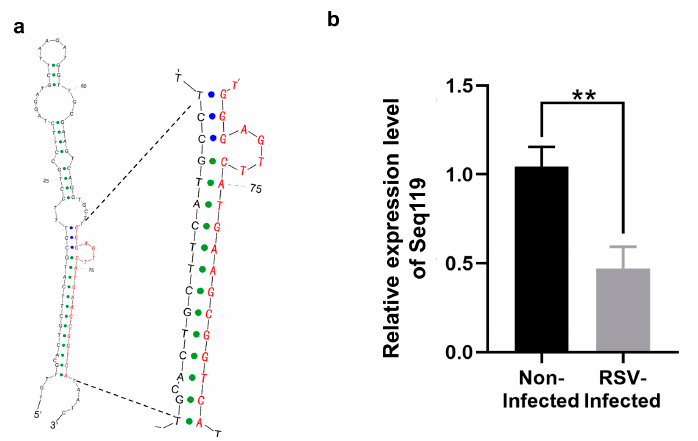
Figure 1. Predicted secondary structures of Seq119 precursor ( a ) and its downregulated expression in RSV-infected rice plants ( b ). Sequences of the putative mature miRNA in precursors are colored with red letters. The relative expression level of Seq119 in RSV-infected rice leaves was analyzed via qRT-PCR. Values are means ± SD. Student’s t test was used to test the significance of the difference (**, p < 0.01).